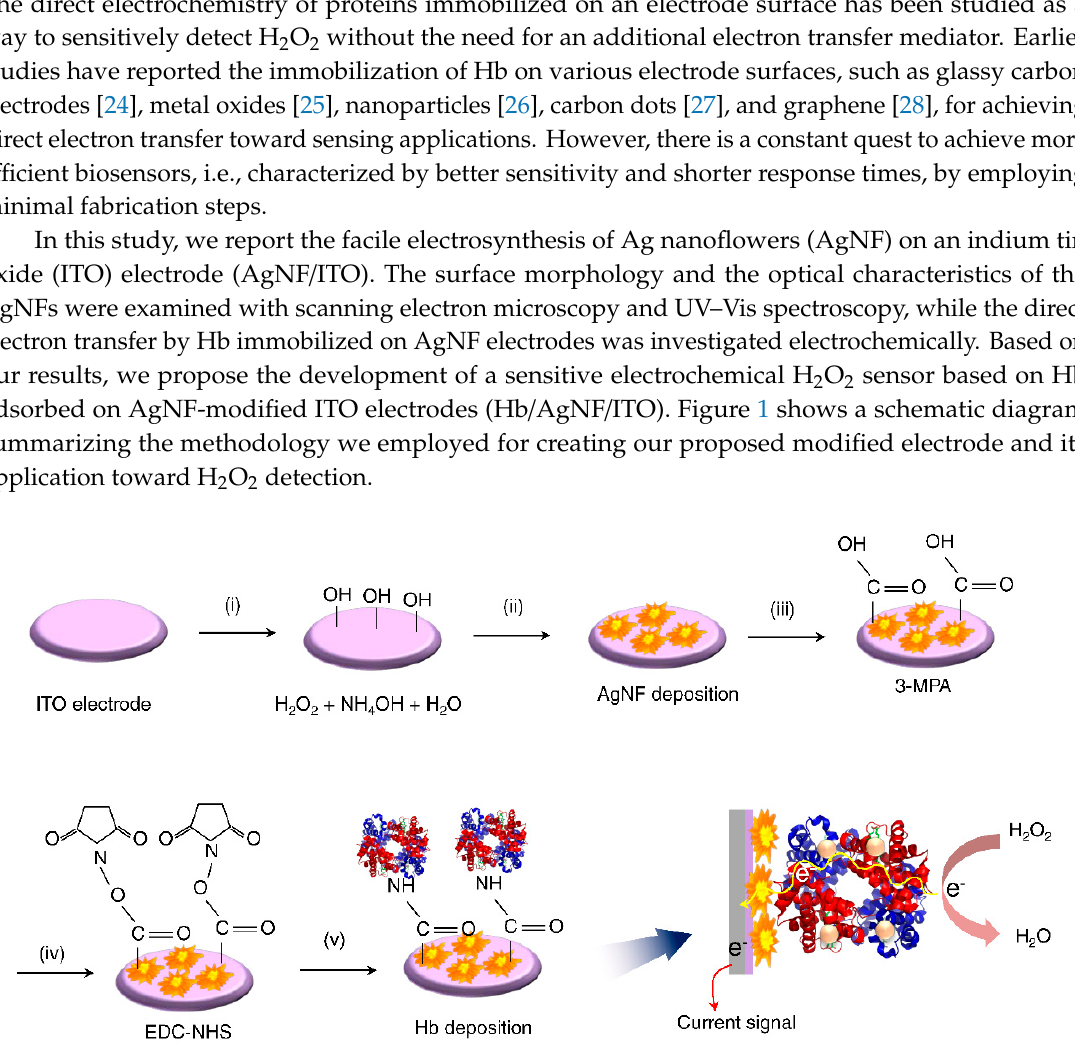
Figure 1. Schematic diagram depicting the surface modifications performed toward the formation of the Hb/AgNF/ITO electrode applied for H 2 O 2 detection.